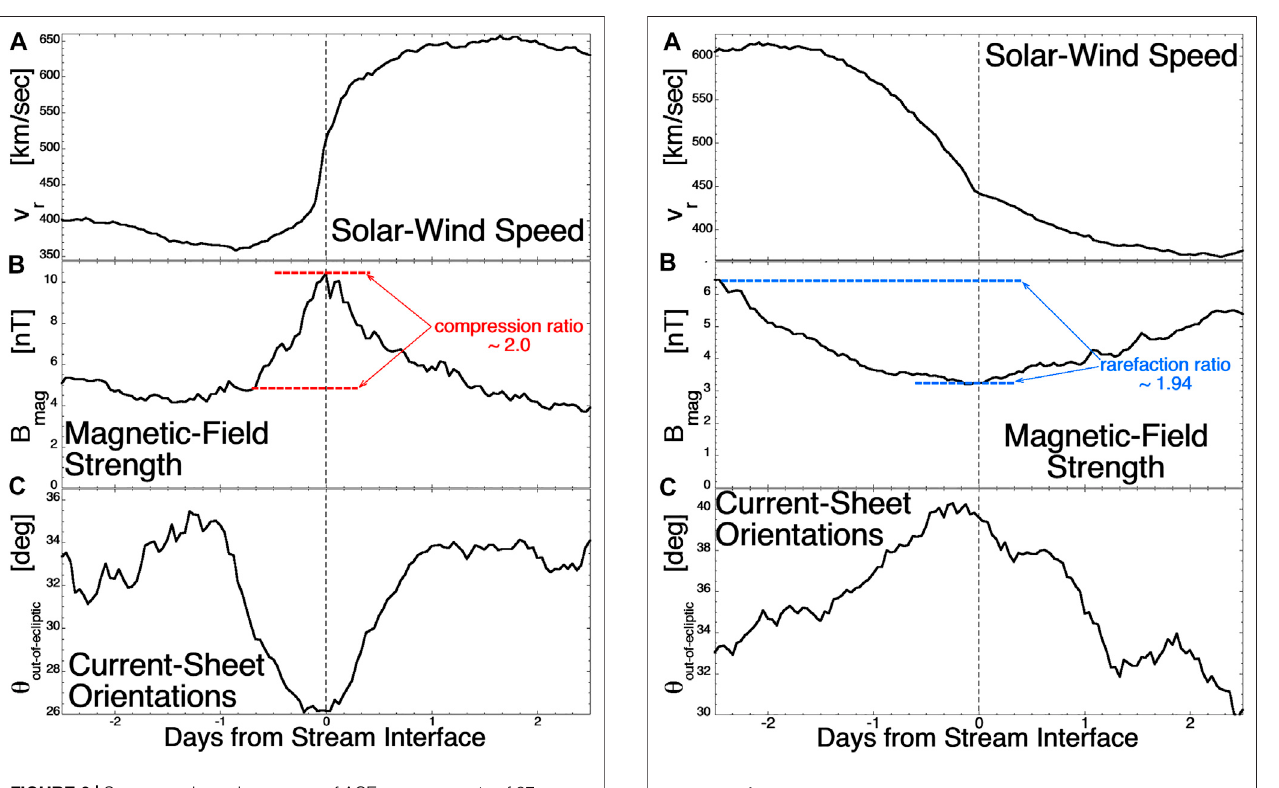
FIGURE 7 | Superposed epoch averages of ACE measurements of 54 trailing-edge rarefaction regions following high-speed streams at 1 AU. Panel (A) plots the solar-wind speed, panel (B) plots the magnetic- fi eld strength, and panel (C) plots the mean value of the angle between the normals of observed current sheets in the plasma and the ecliptic